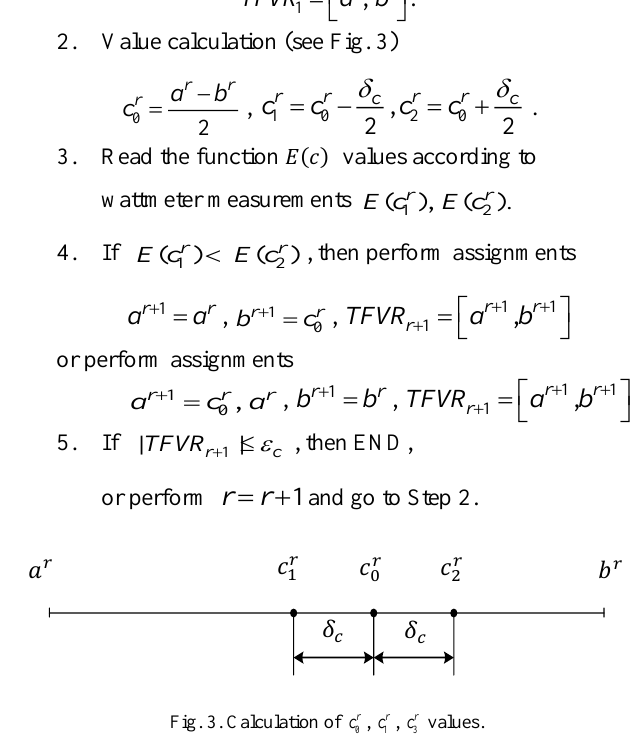
r c , r c , r c values. 1 3 0